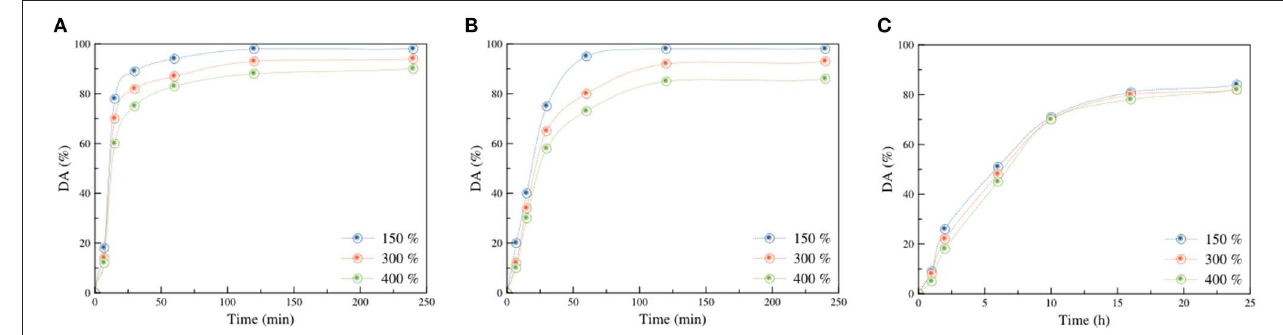
FIGURE 1 | Influence of reaction time on the DA of poly(GMA) grafted s-PP samples using EA (A) , DEA (B) , and TEA (C)